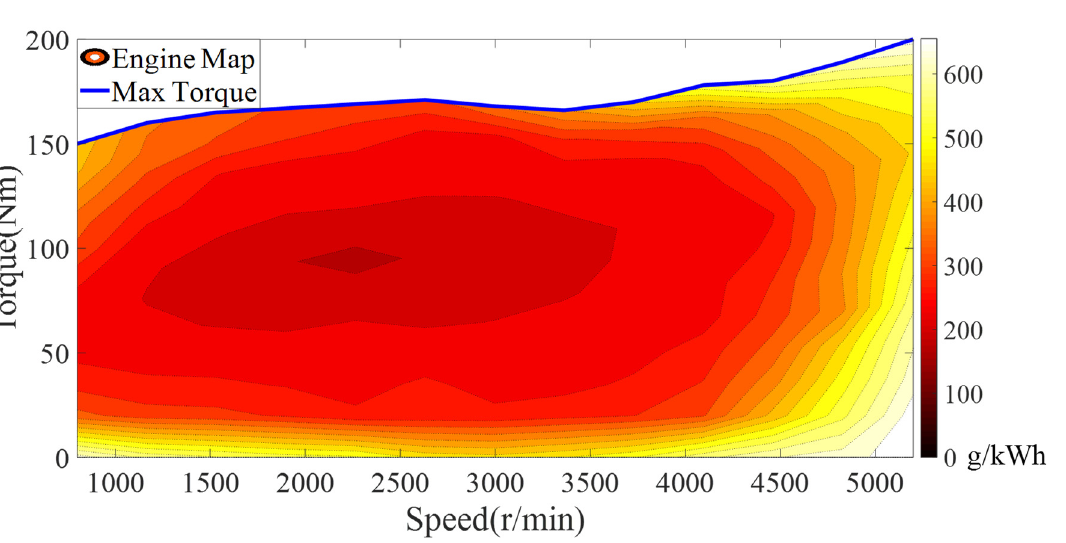
Figure 2. The fuel consumption map of the engine.